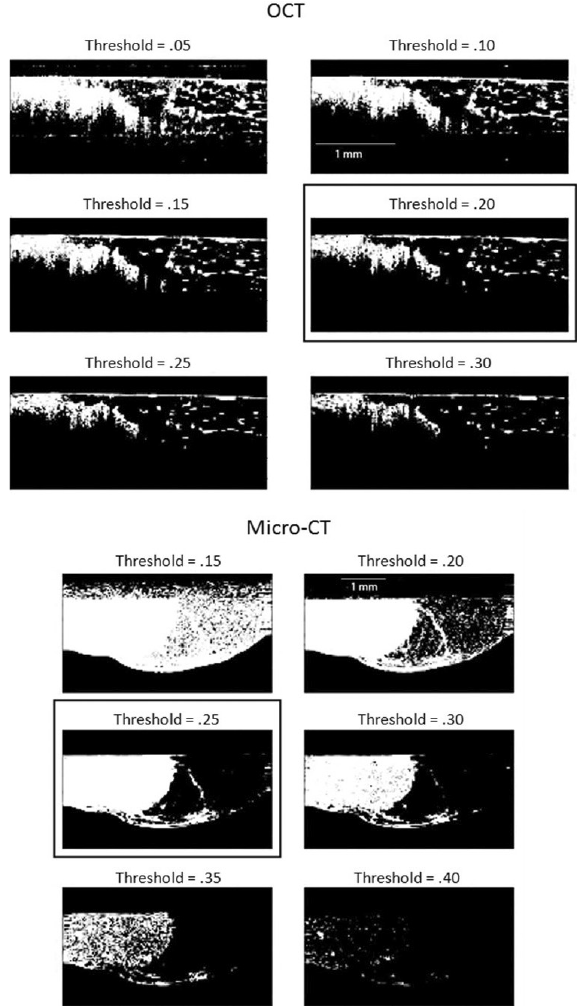
Fig. 2. Optimization of intensity-based ¯ltering. OCT images (top set) with intensity threshold settings from 5 (cid:1) 30% and micro- CT images (bottom set) with threshold values from 15 (cid:1) 40% are shown. Setting threshold values at 20% for OCT and 25% of maximum intensity for micro-CT yielded the best results by visual selection (boxes). The image dimensions were 3 mm (cid:3) 1 : 5 mm and the tumor area is shown on the left side of each